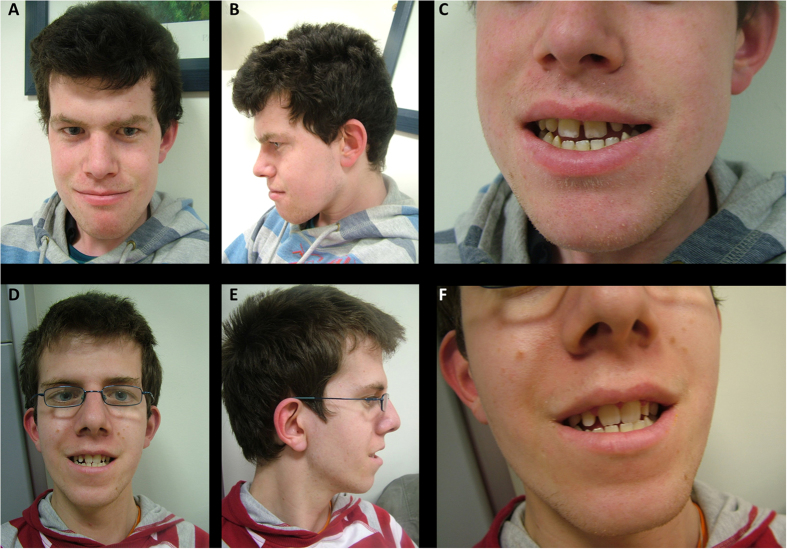
Patient photographs.(A–F) Photograph of patient III:1 and III:2 respectively showing (A,D) coarse features, depressed midface, hypertelorism, upward tufting or horizontal eyebrows, low set ears, coarse hair, (B,E) profile, and (C,F) broad teeth.